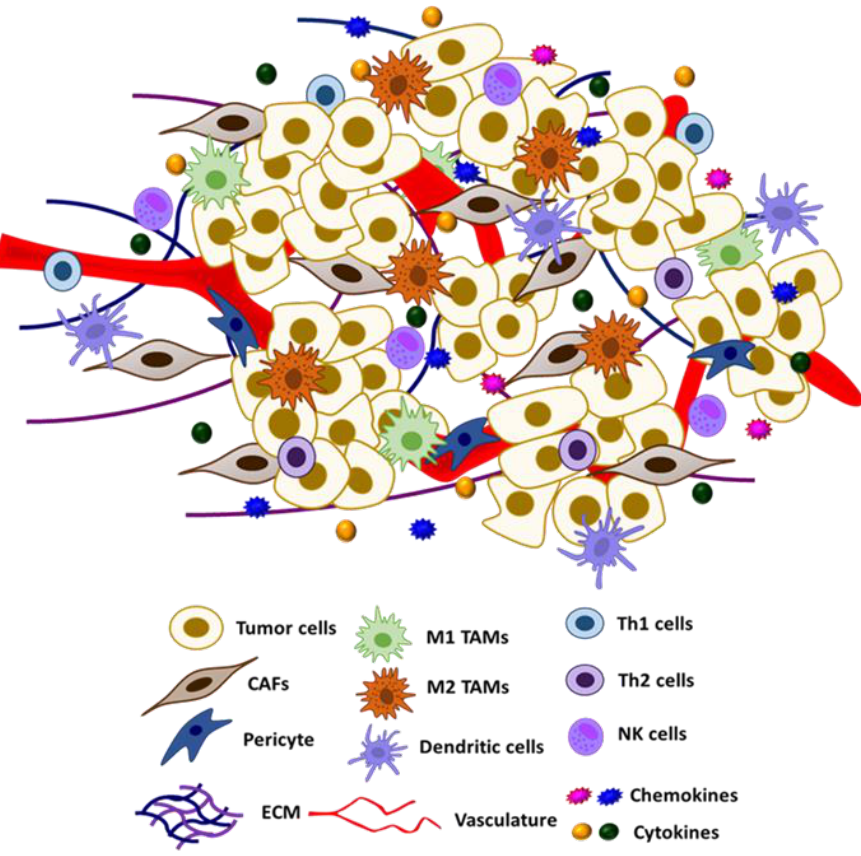
Figure 2. Schematic representation of tumor microenvironment and its constituents.